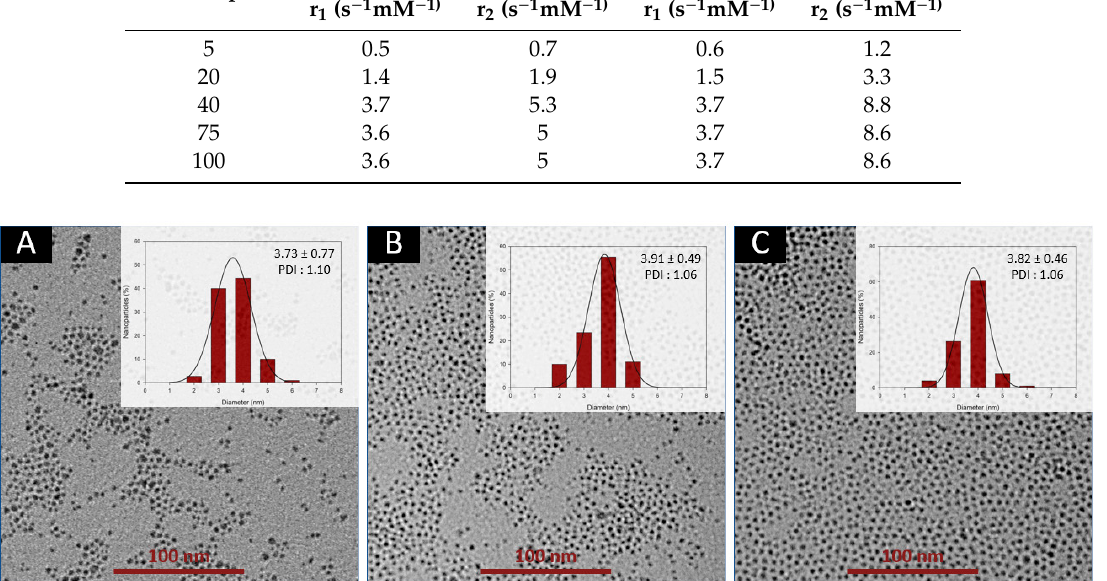
Figure 6. TEM images of the nanoparticles obtained through flow synthesis with BPR of 40 psi ( A ), 75 psi ( B ) and 100 psi ( C ). The scale bar corresponds to 100 nm. Insets show the size distributions determined by statistical analysis.